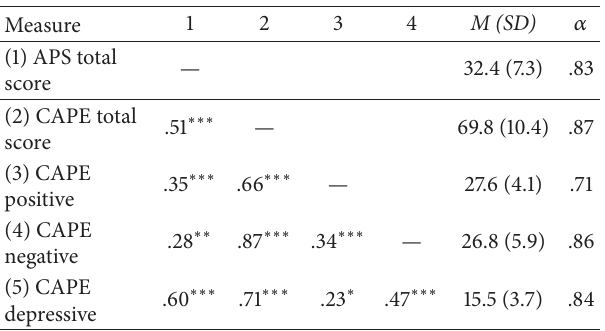
Table 1: Pearson’s correlation coefficients, psychometric data, and scale properties.